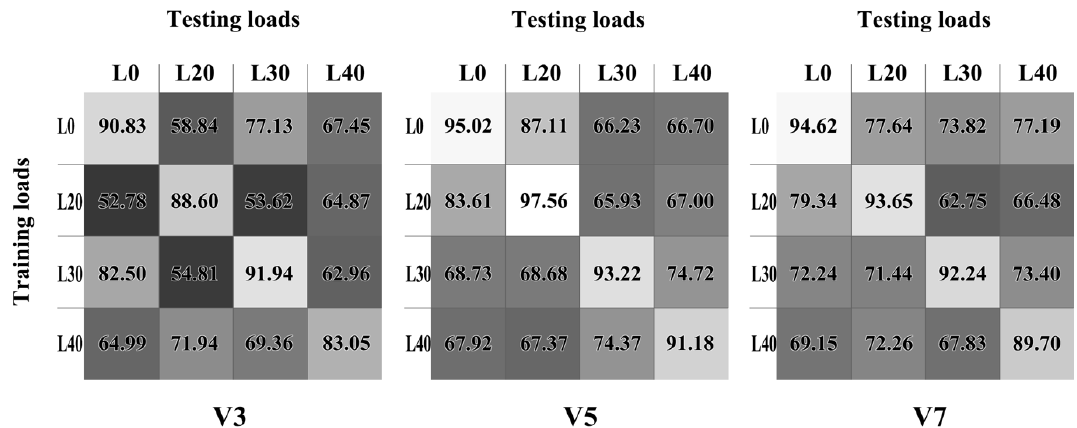
Figure 5. Accuracy of gait recognition (%) matrices under three speeds. Each value in the matrix represents the accuracy of gait recognition from the specified training loads and testing loads (vertical and horizontal axis, respectively). The whiter color means a higher gait recognition accuracy.